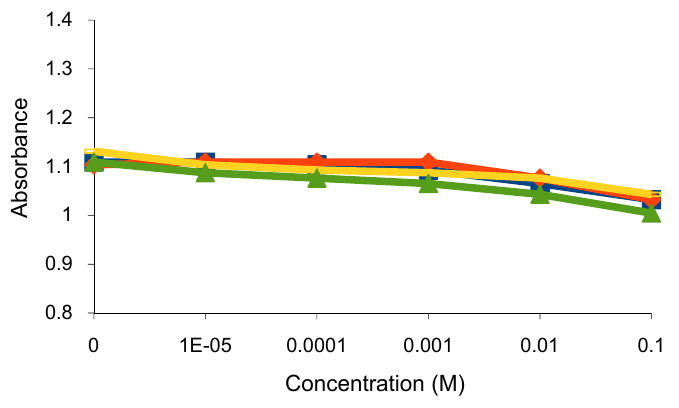
Figure 9. Turbidity absorbance of sensing element vs. concentration of alkali; Na + (